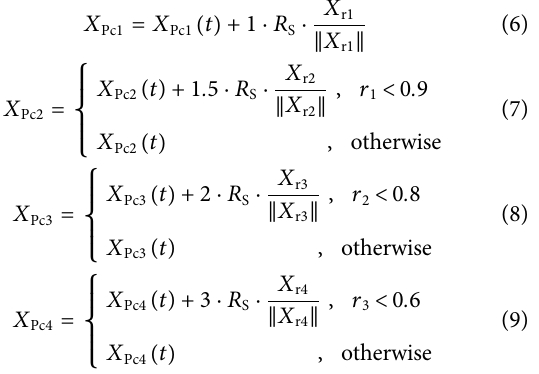
Frontiers in Energy Research |